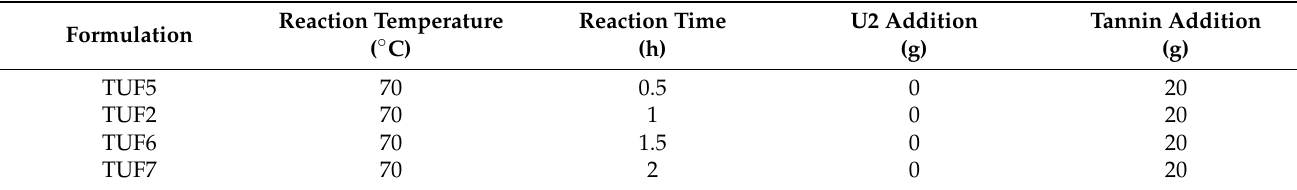
Table 2. Reaction time as a variable for the synthesis of TUF resins.